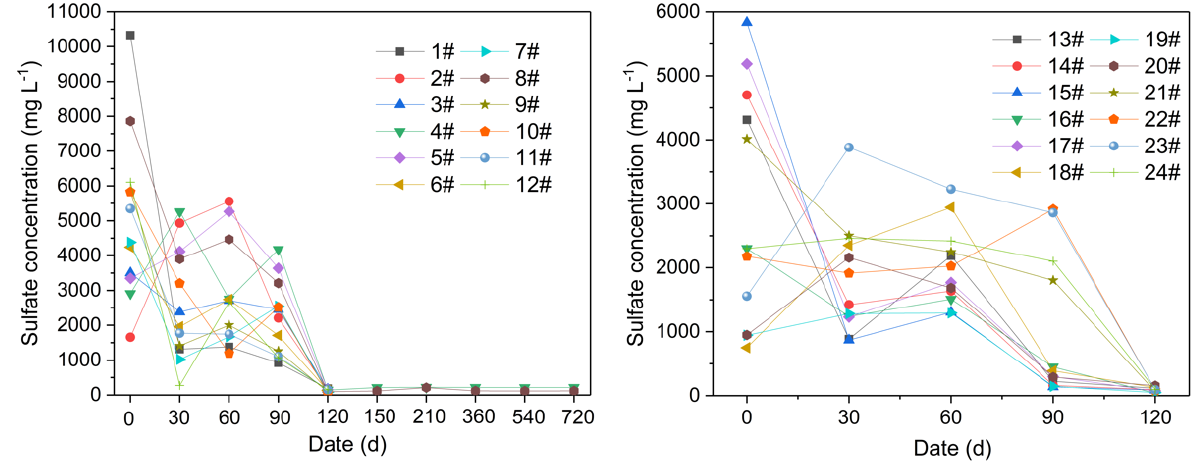
Figure 9. Changes in sulfate concentrations at different treatment and remediation stages.